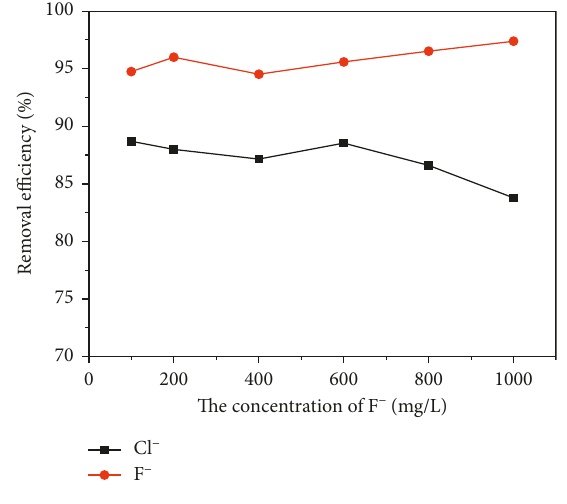
Figure 9: The effect of F